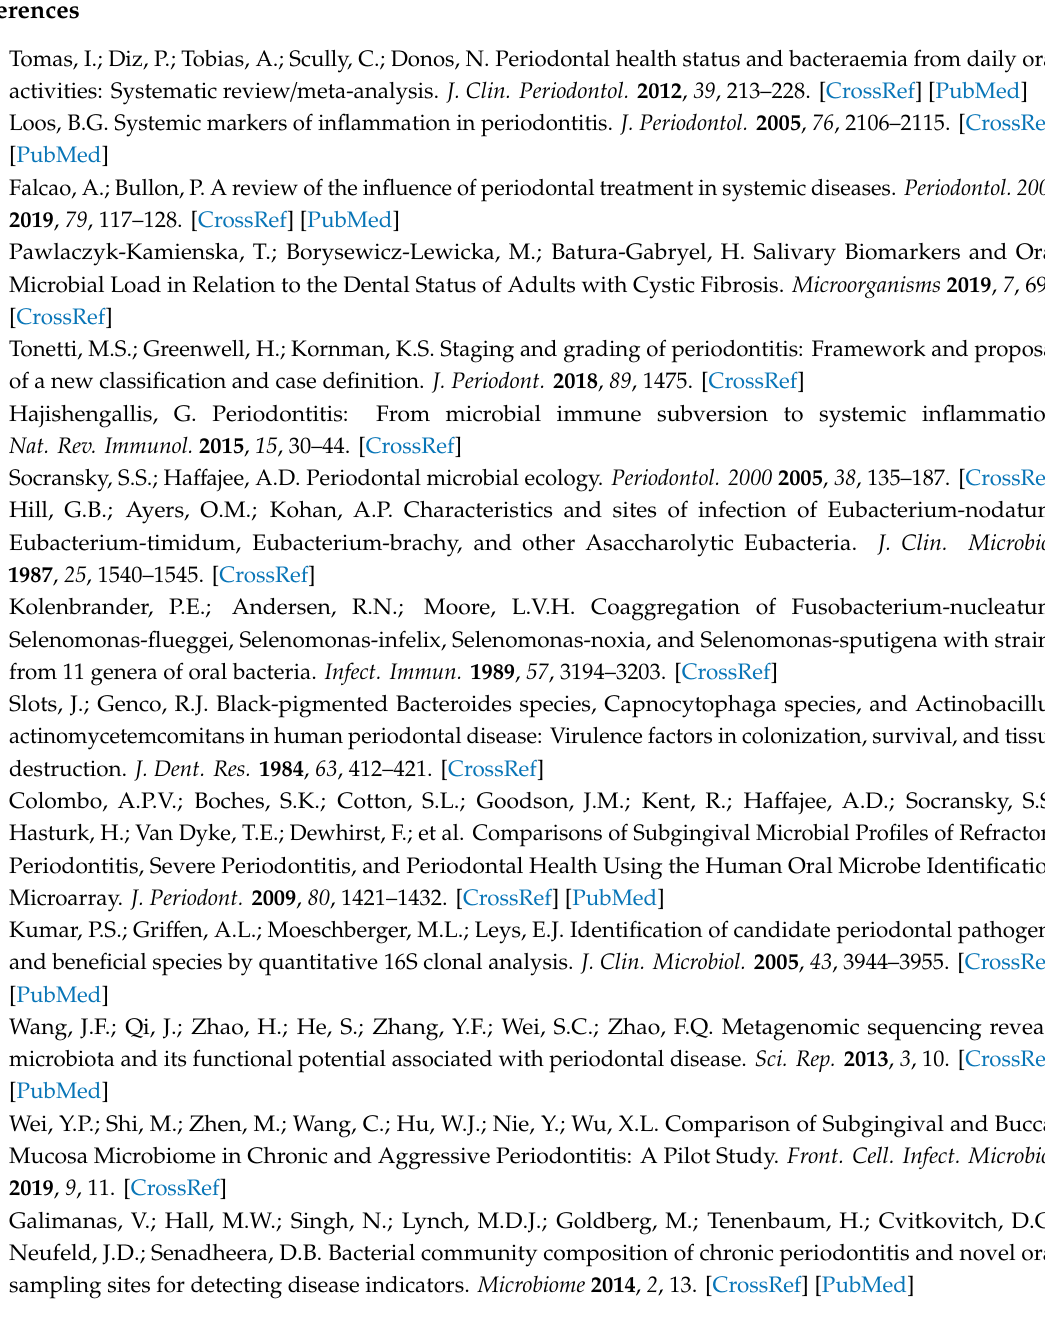
of subjects, Table S3: Summary of the correlation analysis of bacterial species with demographic characteristics and clinical parameters. Table S4: Di ff erential abundance of bacterial species using DESeq2 method, Table S5: Evaluation of prediction models using four feature sets and five machine learning